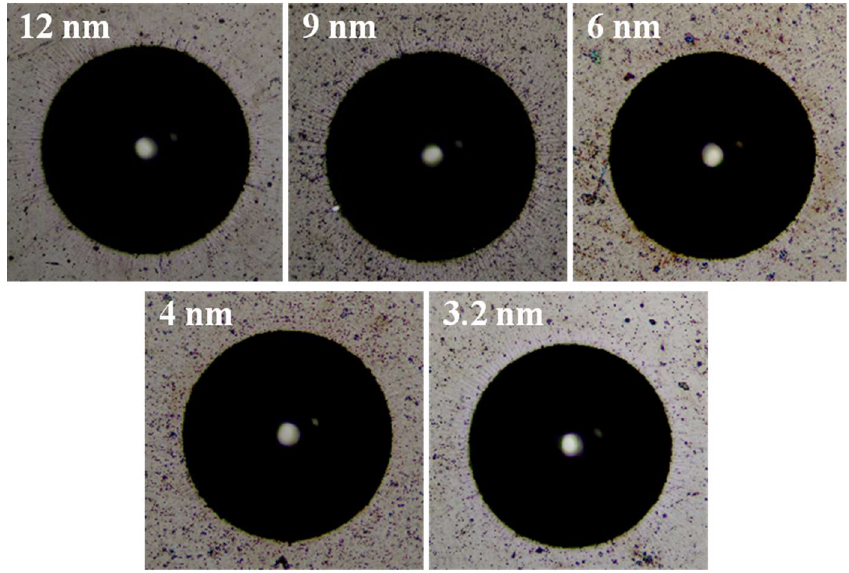
Figure 6. Rockwell indentations of CrN/CrAlSiN multilayer coatings as a function of the bi-layer thickness.